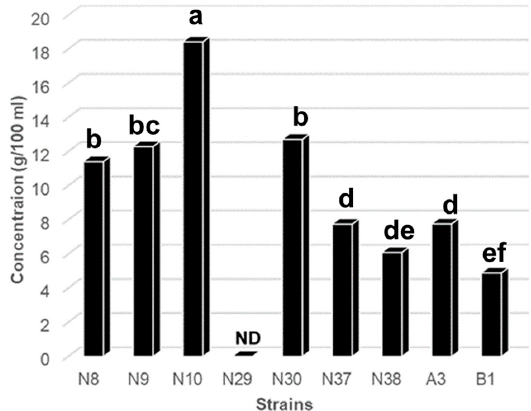
Figure 1. Concentration of GABA in the culture supernatant of the GABA-producing LAB isolated in this study. Values show average ( n = 3). Different letters denoted in column show significant difference ( p < 0.05). ND, not detected.